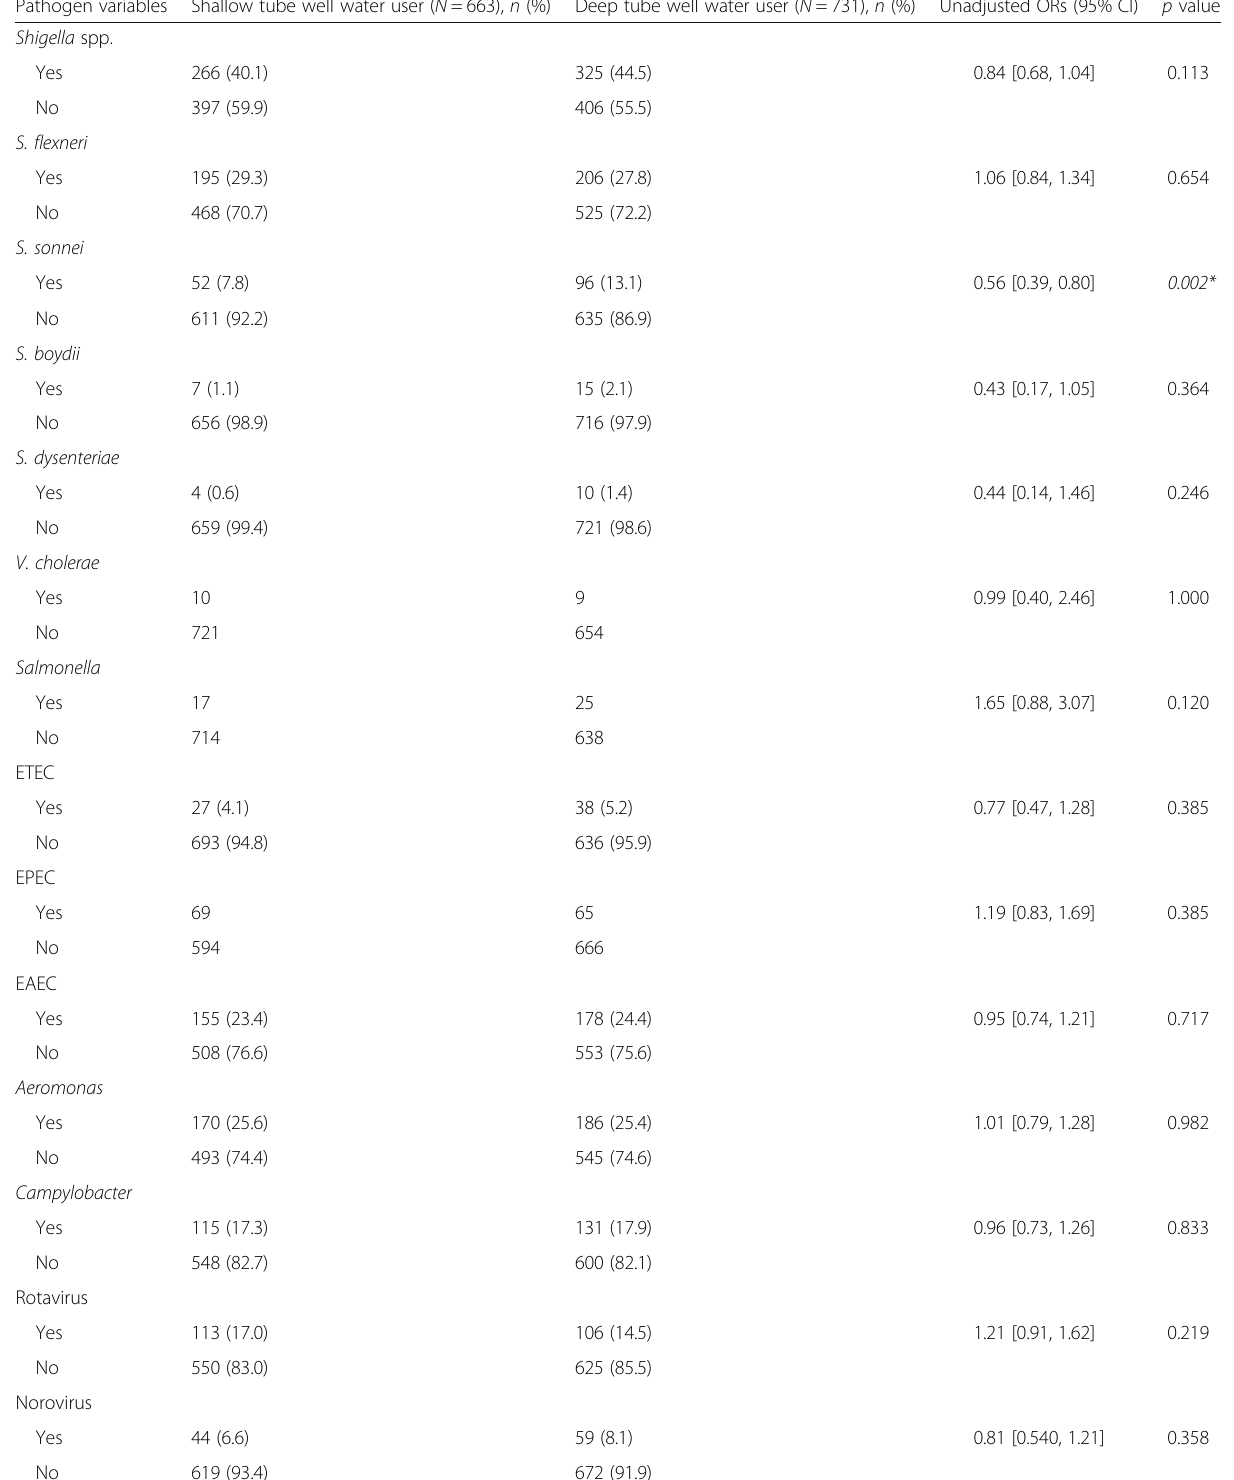
Table 3 Pathogen distribution among under-5 moderate-to-severe diarrheal children from the two types of tube well water user